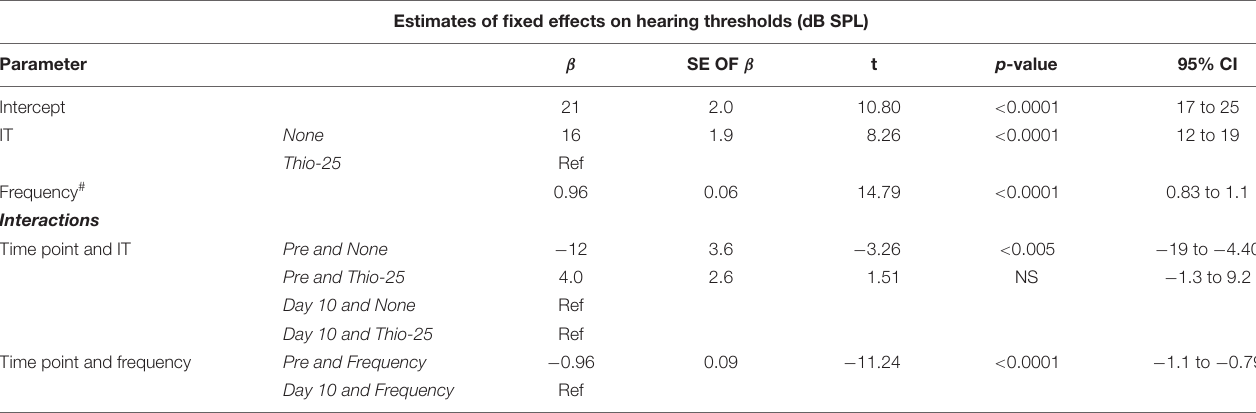
TABLE 2A | Mixed linear modeling of associations of the hearing thresholds in the Thio-25-cispt group ( n = 15) presented in Figure 2 with IT administration, frequency, and time